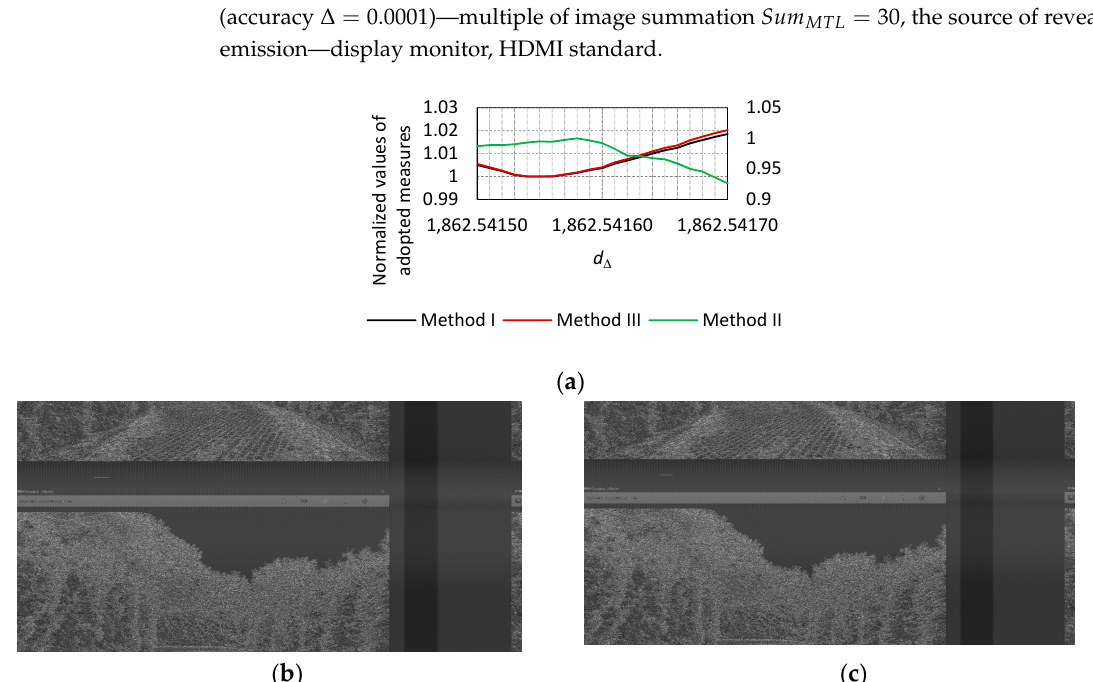
Figure 17. ( a ) The normalized values of the adopted measures (method I, II and III) calculated in domain of image line length d ∆ for the accuracy ∆ = 0.00001 (for the original image shown in Figure 7a) and images reconstructed on the basis of the recorded revealing emission signals at frequency f o = 1334 MHz (receiving bandwidth BW = 50 MHz, accuracy ∆ = 0.00001), ( b ) for estimated line length d ∆ = 1953.64892 and ( c ) for estimated line length d ∆ = 1953.64893 —multiple of image summation Sum MTL = 30, the source of revealing signal emission—display monitor, HDMI standard.